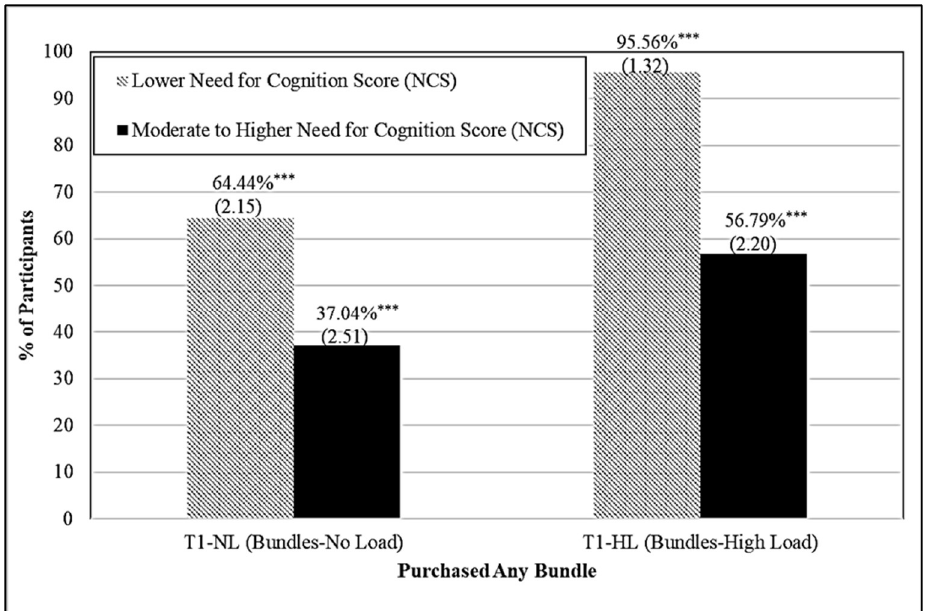
Figure 2. Food Bundle Selection by Treatment (when Bundles were Displayed) and Need for Cognition Score (NCS). NOTE: Standard errors in parentheses. Differences within treatments between need for cognition scores (NCS) are significant at the 1% *** level.